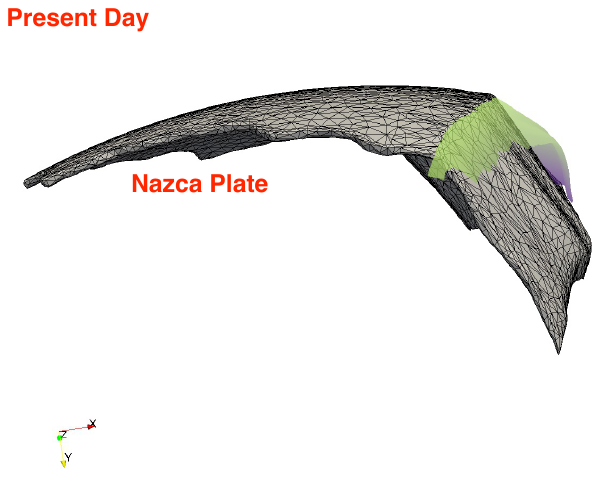
Figure A3. South side view of the Nazca plate at present day for geodynamic model input. The green to purple coloured topology represents the depth of the Nazca slab from the Slab1.0 (Hayes et al., 2012) interpretation. The black mesh over the plate indi- cates the resolution of the model. The Slab1.0 interpretation is made slightly transparent to see the extent of modelled plate.